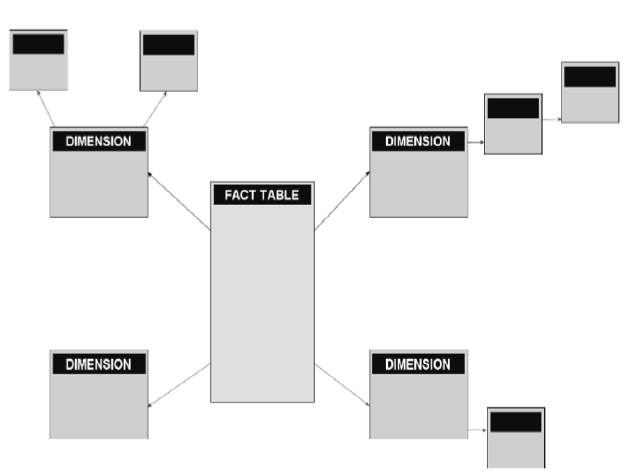
Fig. 1. Configuration basic schematic elements – star.